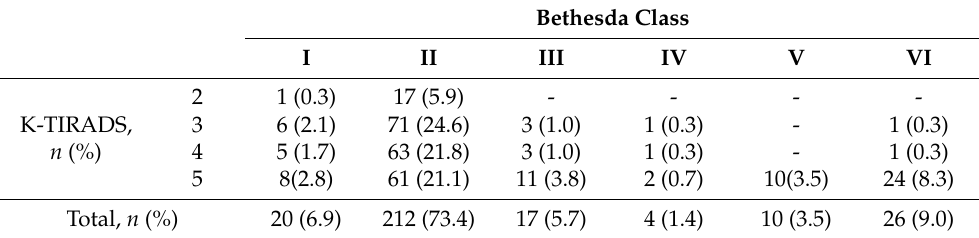
Table 3. Summary of K-TIRADS categories by Bethesda classes.